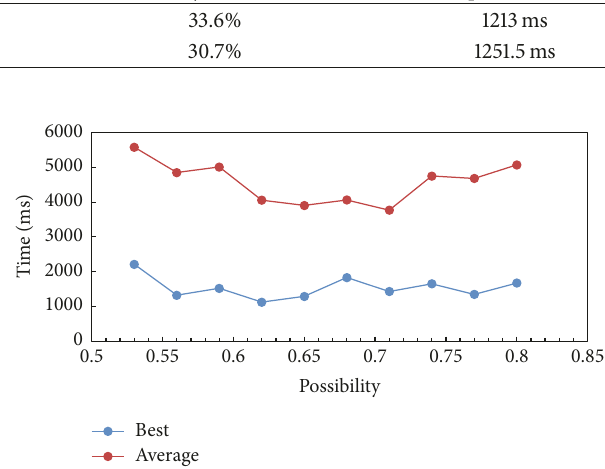
Figure 15: Comparison of different crossover possibility in